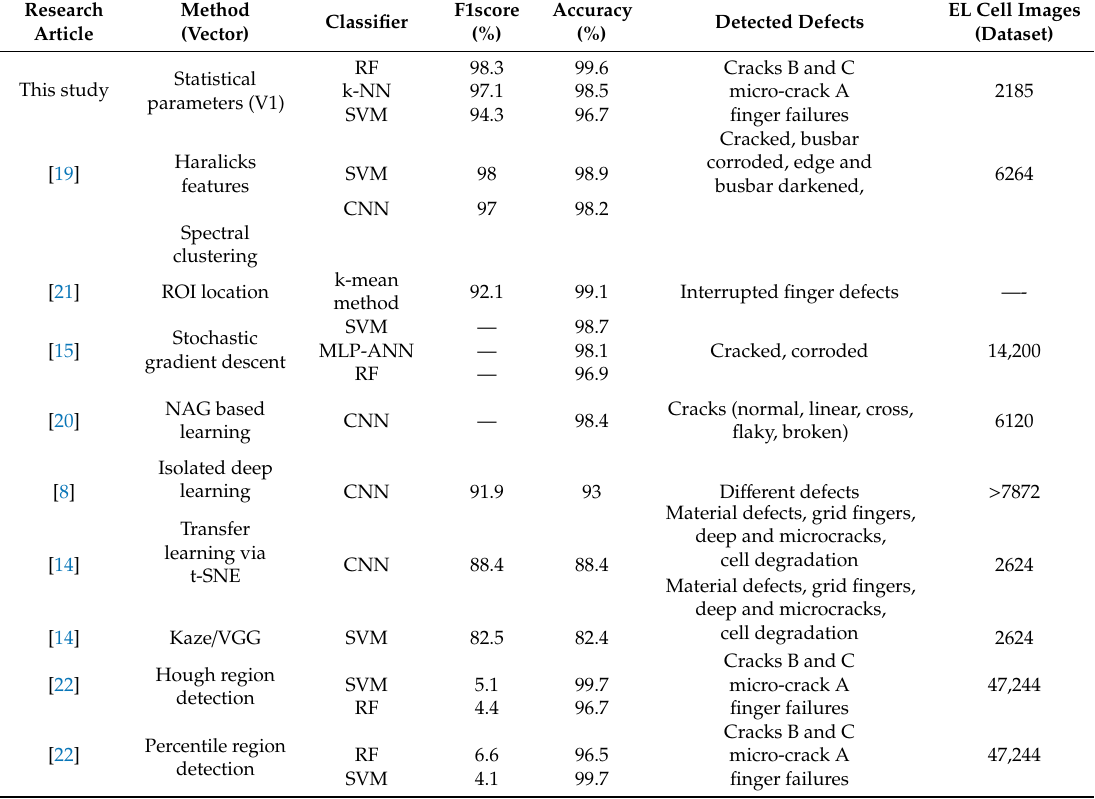
Table 4. Summary of the performance of various automated fault classification for EL